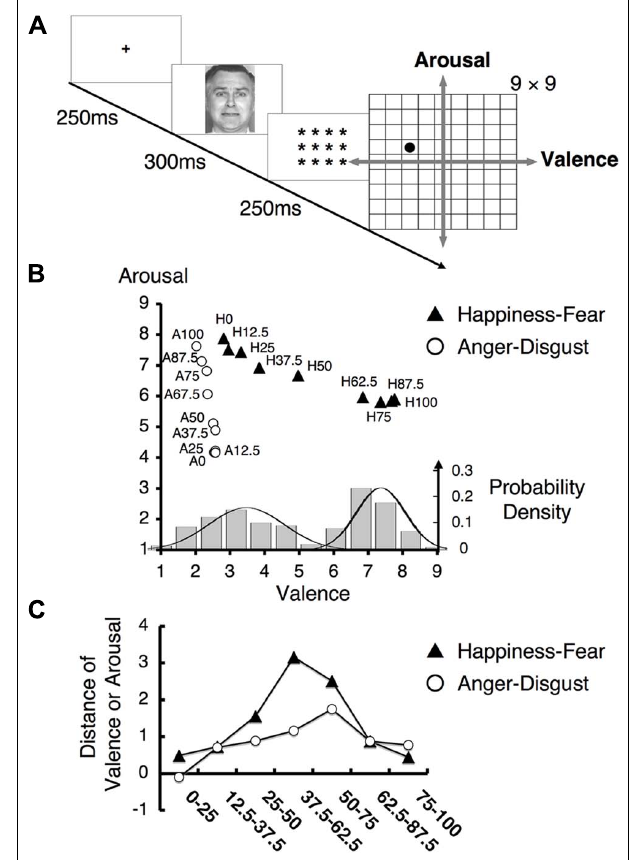
FIGURE 3 | Behavioral results for theAffect Grid task. (A) The experimental design of the Affect Grid task. Subjects were asked to rate each facial emotion by selecting the appropriate location on a two-dimensional square grid representing the emotional space.This grid represents nine levels of both the valence and arousal dimensions; in particular, subjects rated each emotion from “1” = “unpleasant” to “9” = “pleasant” in the valence dimension and from “1” = “low” to “9” = “high” in the arousal dimension. (B) The mean ratings on the Affect Grid task.The labels “H12.5” and “A75” indicate the 12.5% happiness and 75% anger facial stimuli, respectively.The ratings for the happiness − fear continuum were nearly parallel to the valence axis, whereas the ratings for the anger–disgust continuum were approximately parallel to the arousal axis. (Bottom)The histogram indicates how frequently each facial stimulus on the happiness–fear continuum was assigned to each level of the valence scale on the grid representing the emotional space.The displayed data were obtained from every study participant and were averaged for each type of stimulus across all participants.The solid lines indicate normal distributions. (C) The mean differences in valence and arousal ratings between faces separated by two steps along the happiness–fear continuum and the anger–disgust continuum, respectively.The label “75–100” refers to the difference in valence (arousal) rating between the 75% happiness (anger) image and the 100% happiness (anger) image.